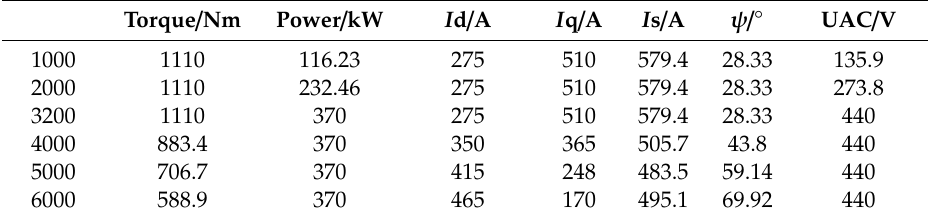
Figure 5. Operating characteristic curve and drive control of the PMSM. Table 3. Motor operating points under different working conditions.